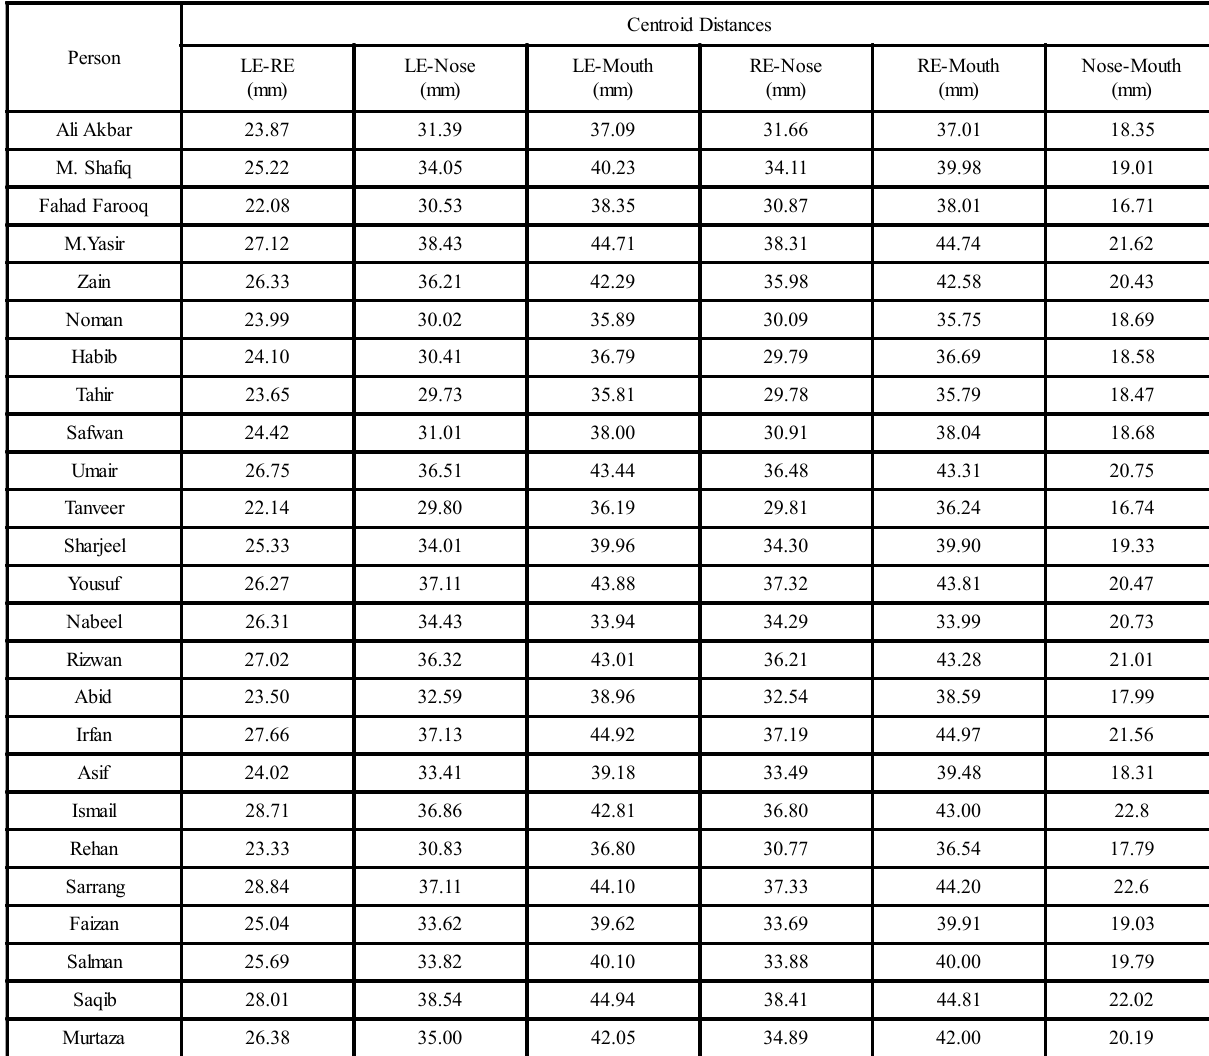
TABLE 1: CENTROID DISTANCES STORED IN THE